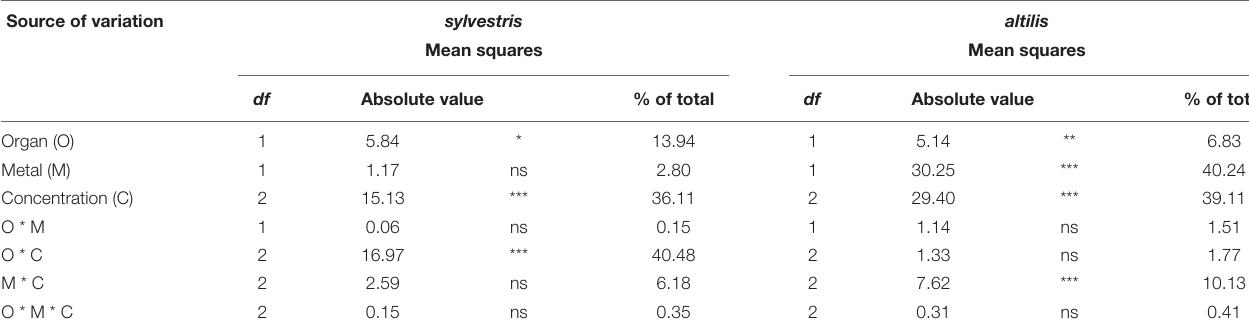
TABLE 2 | Analysis of variance of plant length, separated in shoot and root, measured after 21 days of treatment with As and Cd. Source of variation sylvestris altilis Mean squares Mean squares Absolute value